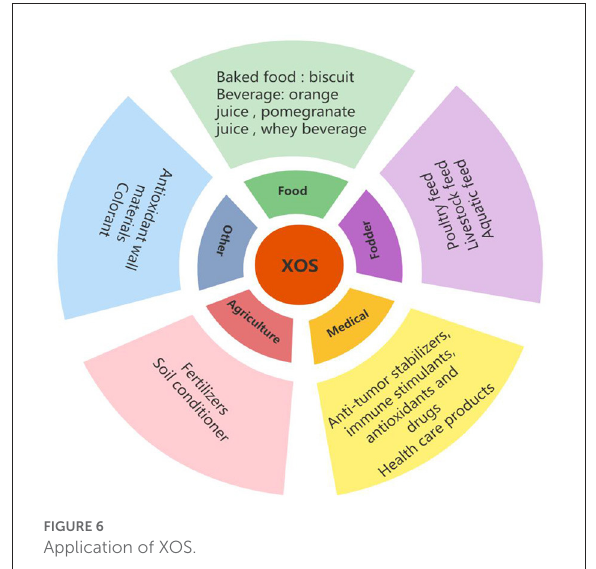
FIGURE6 Application of